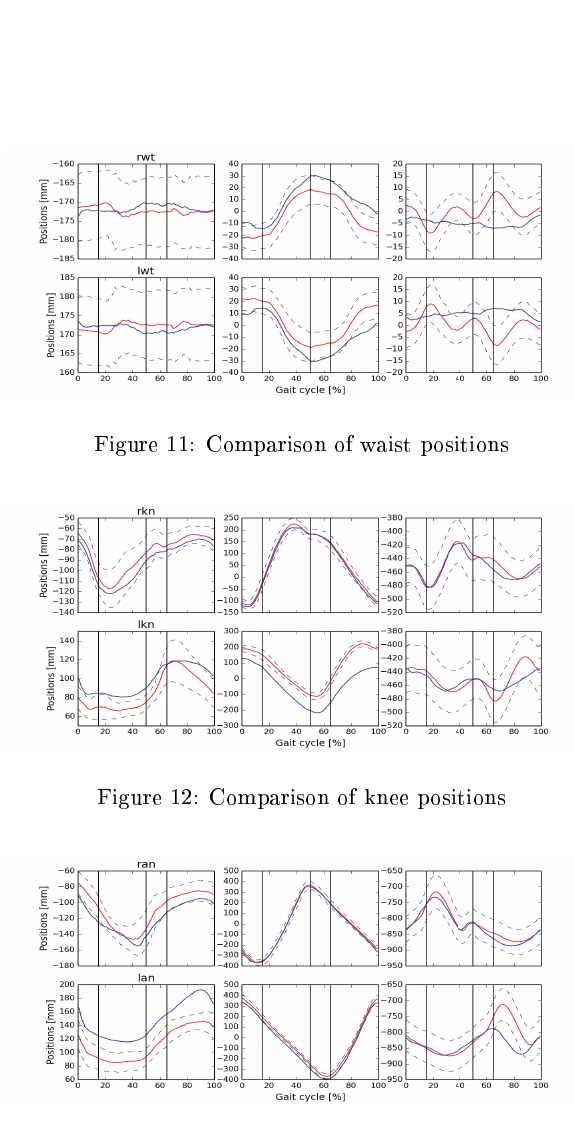
Figure 10: Comparison of wrist positions